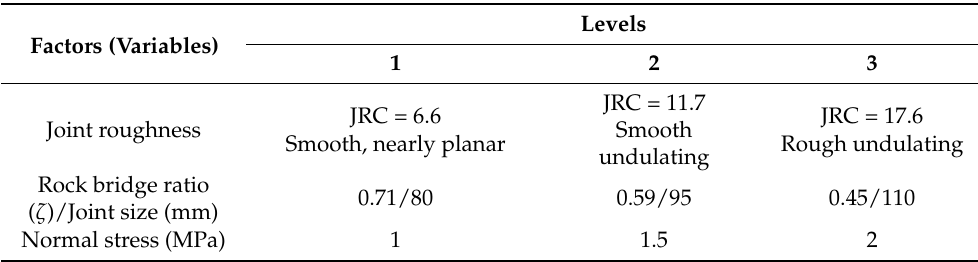
Table 2. Selected levels for the factors affecting the shear behavior of specimens with a non-persistent rough